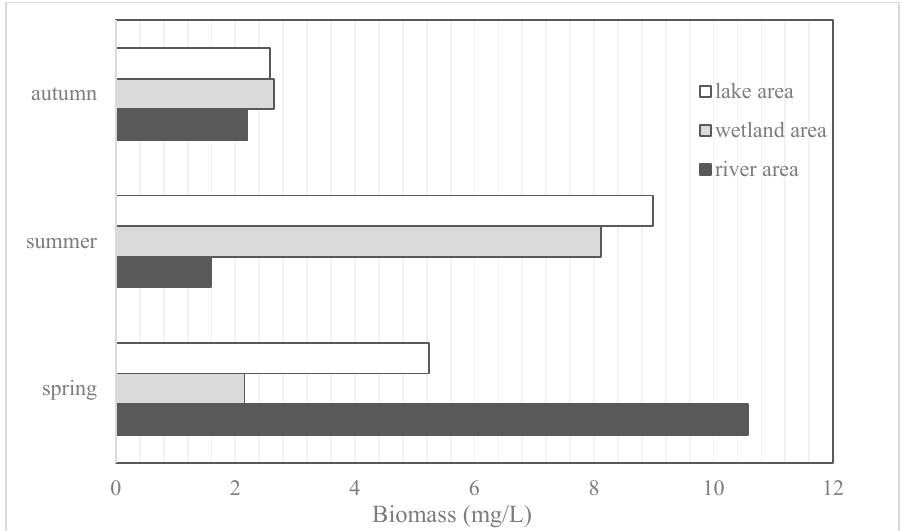
Figure 3. Distribution of average phytoplankton biomass in sampling area.